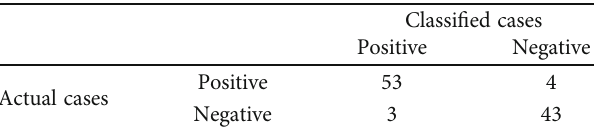
Table 11: Confusion matrix for the EEG-DenseNet model with fi ne tuning for 100 cases for right